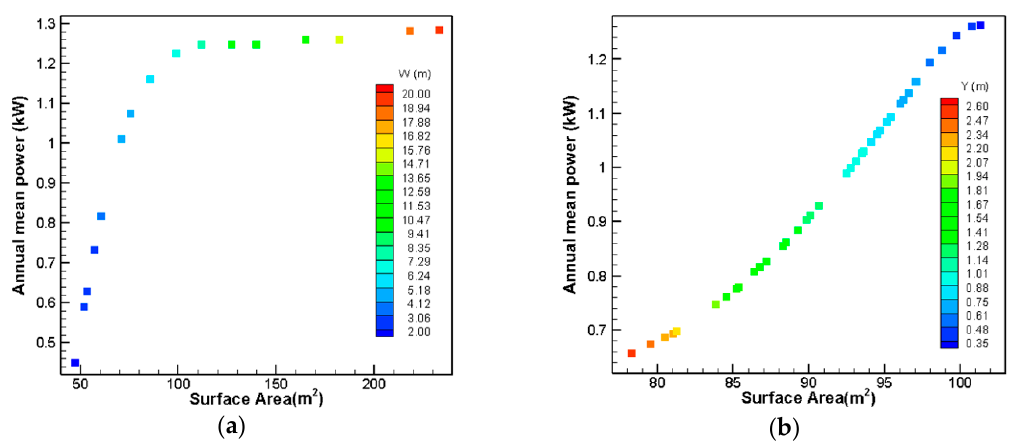
Figure 13. Pareto fronts for ( a ) the width and ( b ) the height of the triangular part of the bottom chamfered shape.